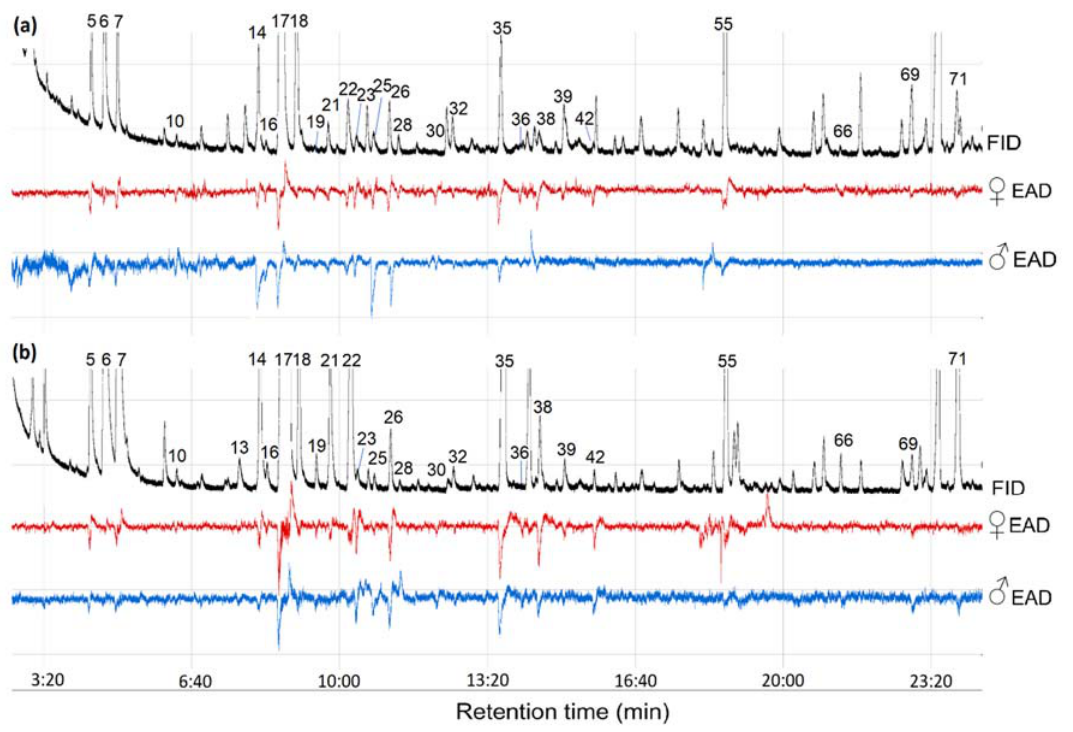
Figure 3. Representative GC-EAD recordings of Rhagoletis batava female and male responses to Hippophae rhamnoides fruits odours at two ripening stages: unripe soft green fruits ( a ) and ripe orange fruits ( b ). FID, flame ionization detector; EAD, electroantennographic detector; DB-Wax capillary column (30 m × 0.25 mm × 0.25 μ m; Agilent Technologies, Santa Clara, CA, USA). FID peaks are numbered according to Tables 1 and 2.